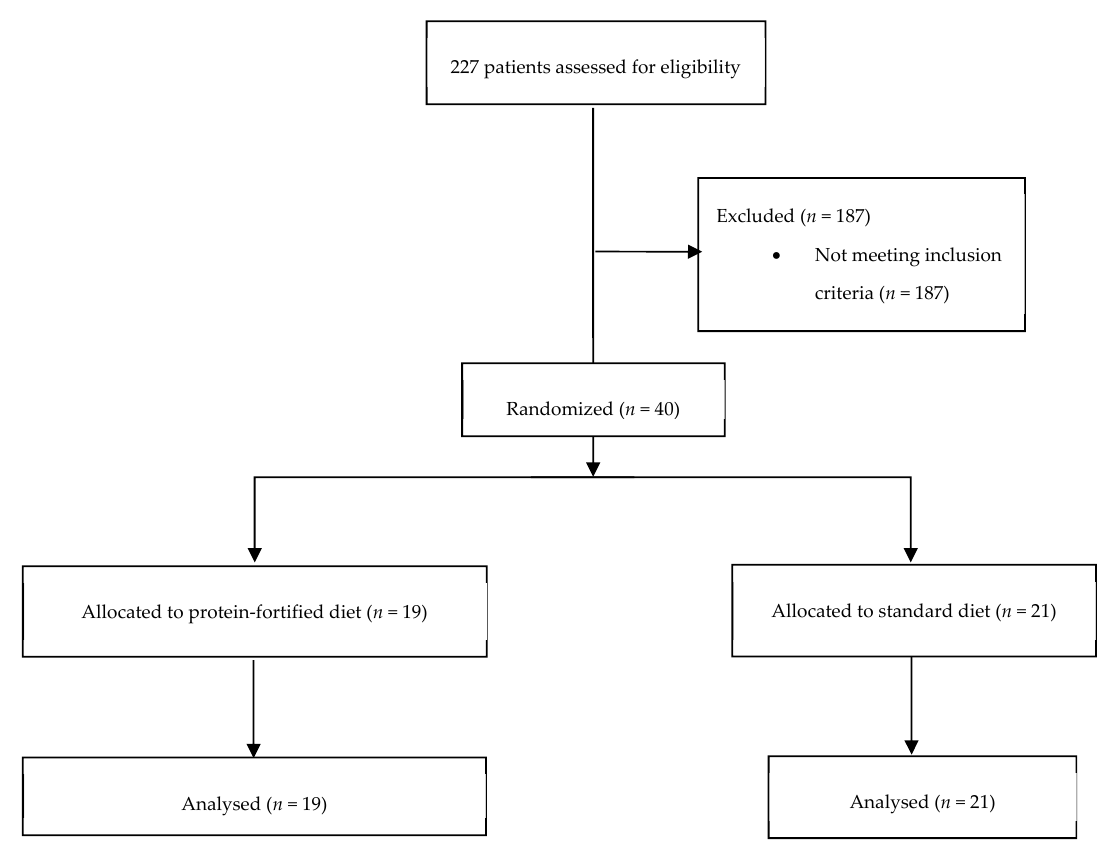
Figure 1. Flowchart of patient recruitment and allocation to study treatments.